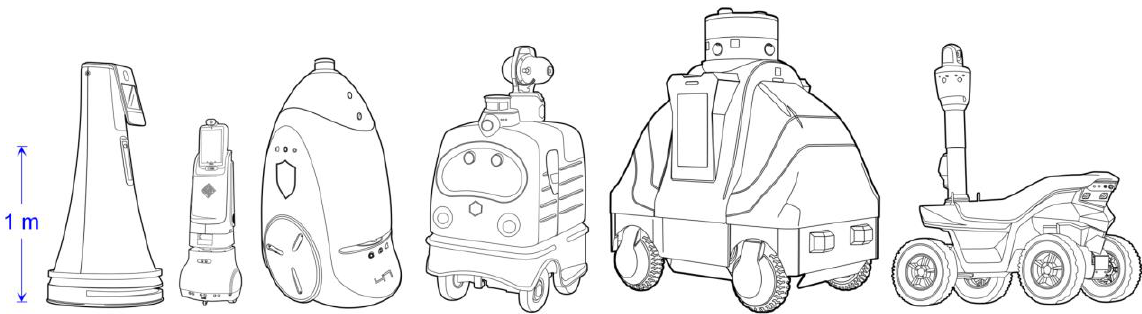
Figure 1. Size and appearance of current security robot models. COBALT, O-R2, K5, PATORO, ROAMEO, and S5.2 (from left to right). Table 1. Comparison of current security robot